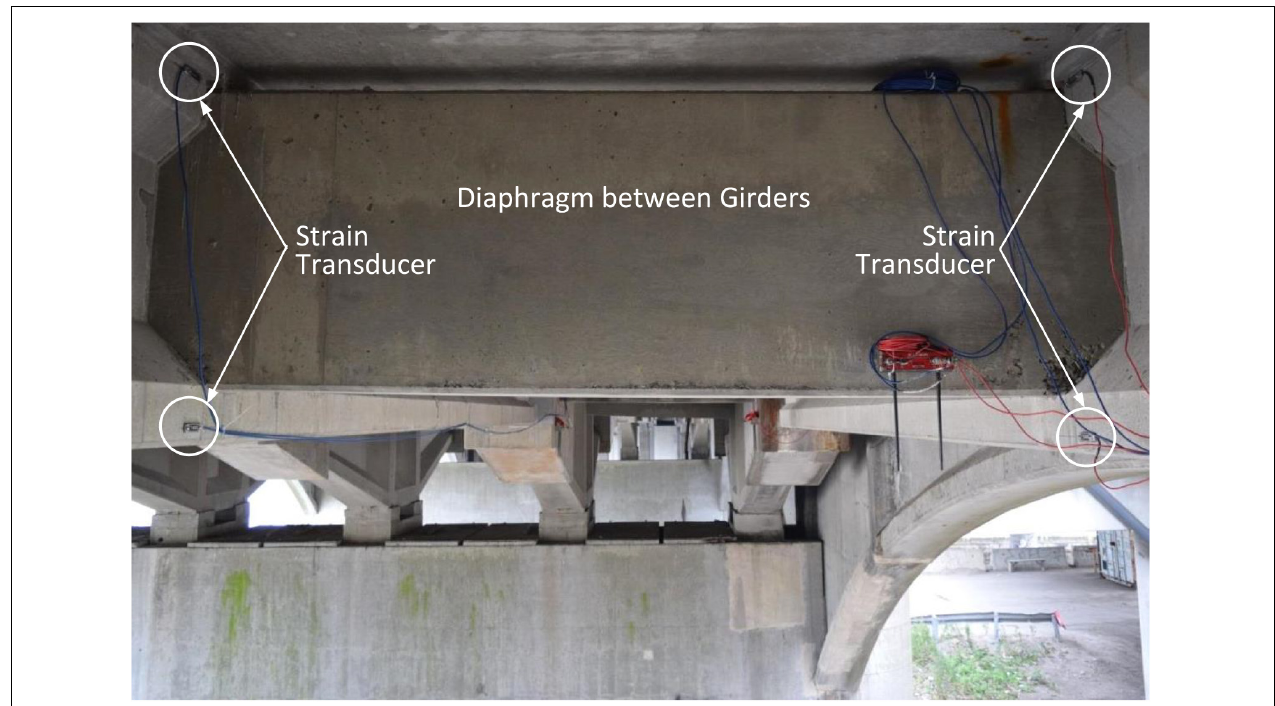
FIGURE 7 | Strain transducers on top and bottom flanges of drop-in girder at